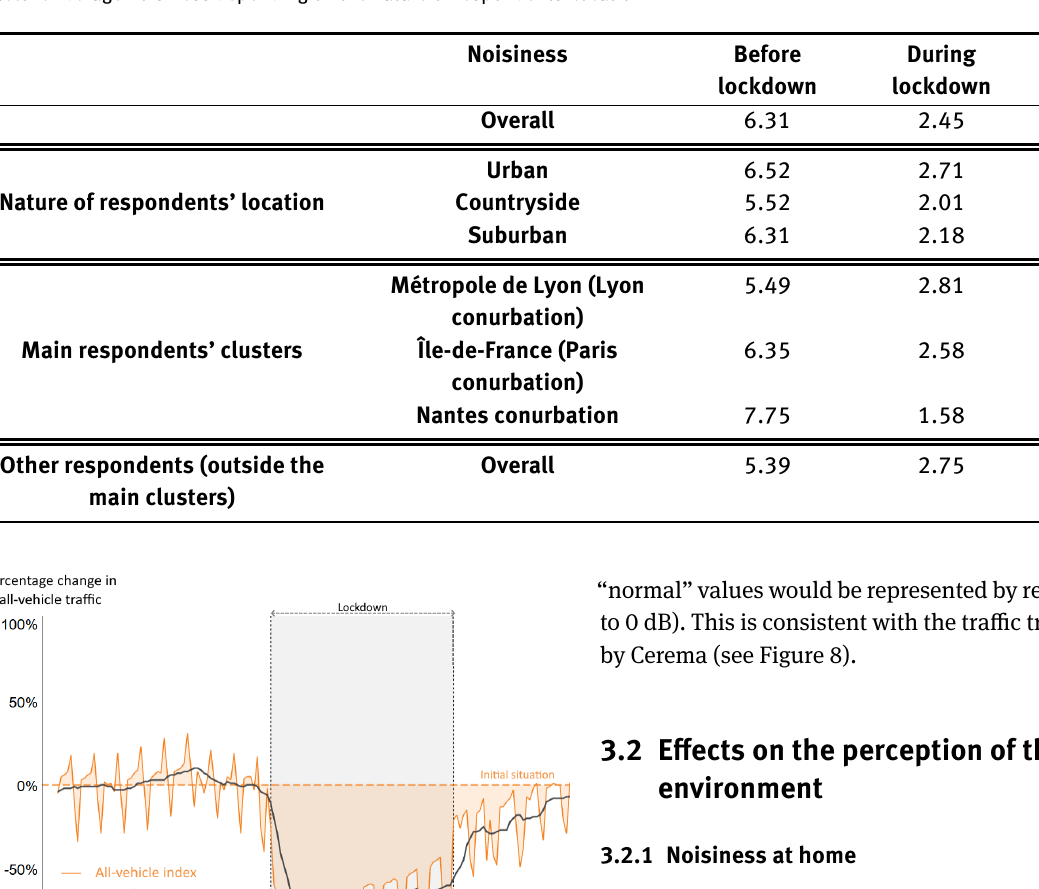
Table 1: Average noisiness depending on the nature of respondents’ location